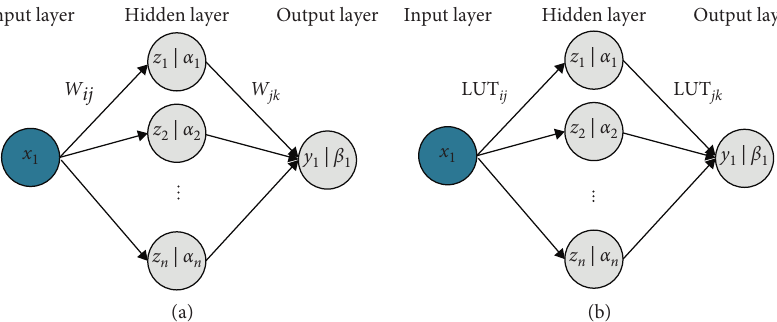
Figure 4: Illustration of the traditional BP neural network (a) and LNN (b). Both plots have only one input node x one hidden layer in neural network. z j represents hidden layer nodes. LUT ij and LUT jk in Figure 4(b) are used to replace weights w ij and w jk in Figure 4(a).